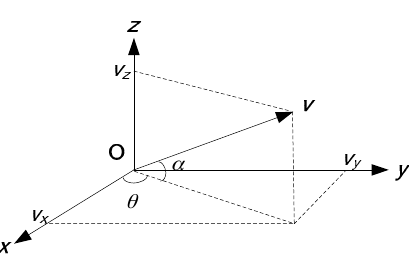
Figure 2. The projection of velocity v and its three orthogonal components v x , v y , v z , considering θ , α